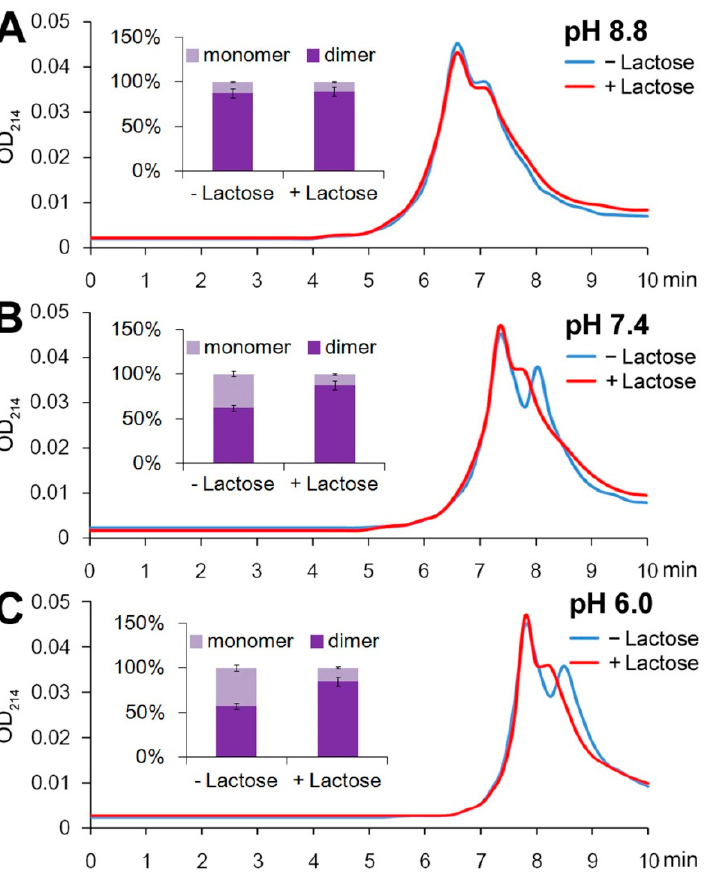
Figure 2. Effect of pH on Gal-10 monomer–dimer equilibrium. The protein was diluted to 10 µ M in PBS–azide buffer at pH 8.8 ( A ), 7.4 ( B ), and 6.0 ( C ) with or without 1 mM lactose and incubated for 24 h. The samples were analyzed by SEC HPLC using PBS–azide buffer at pH 8.8 ( A ), 7.4 ( B ), and 6.0 ( C ). Quantitative data of Gal-10 monomers and dimers are shown on the left side of each panel. Bars represent the standard deviations of three independent replicates.